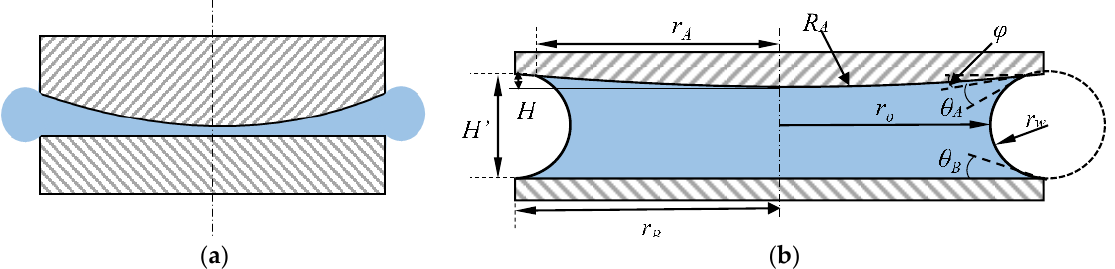
Figure 3. Capillary bridge between curved surface and flat surface: ( a ) the state in which the droplet is compressed between the two surfaces; ( b ) the two surfaces are separated and the droplets form a capillary bridge.